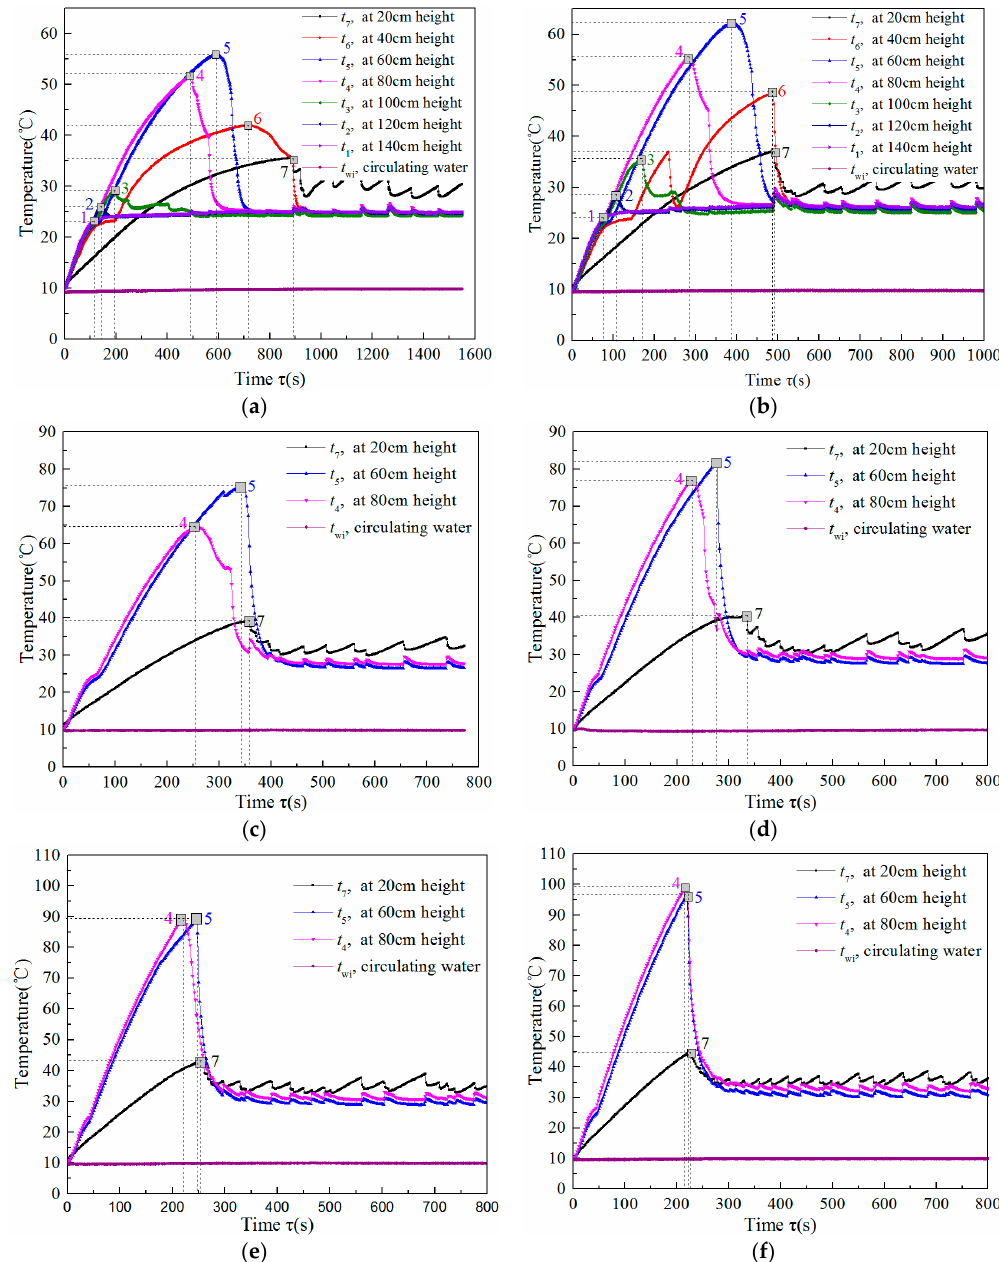
Figure 7. Variations of pipe wall temperatures throughout operation time under different heating power conditions: a heating power of ( a ) 20; ( b ) 30; ( c ) 40; ( d ) 50; ( e ) 60 and ( f ) 70 W. Based on the principle presented in Section 3.2.2, the heat pipe’s start-up time ( ∆ τ s ) was defined as the time when inflection point 7 appeared. When the heating power was 20, 30, 40, 50, 60 and 70 W, the starting time of the heat pipe was 890, 490, 356, 334, 248 and 226 s, respectively. The start-up time was shortened with the increase of heating power. That is, a lower solar radiation